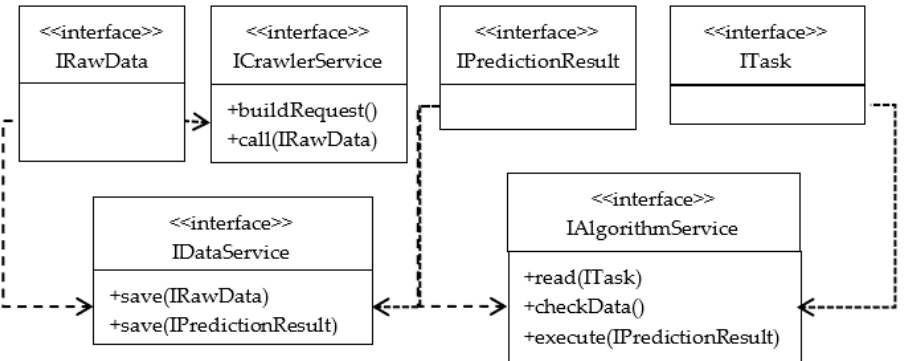
Figure 5. Call relationship between interfaces of AS, CS, DS.